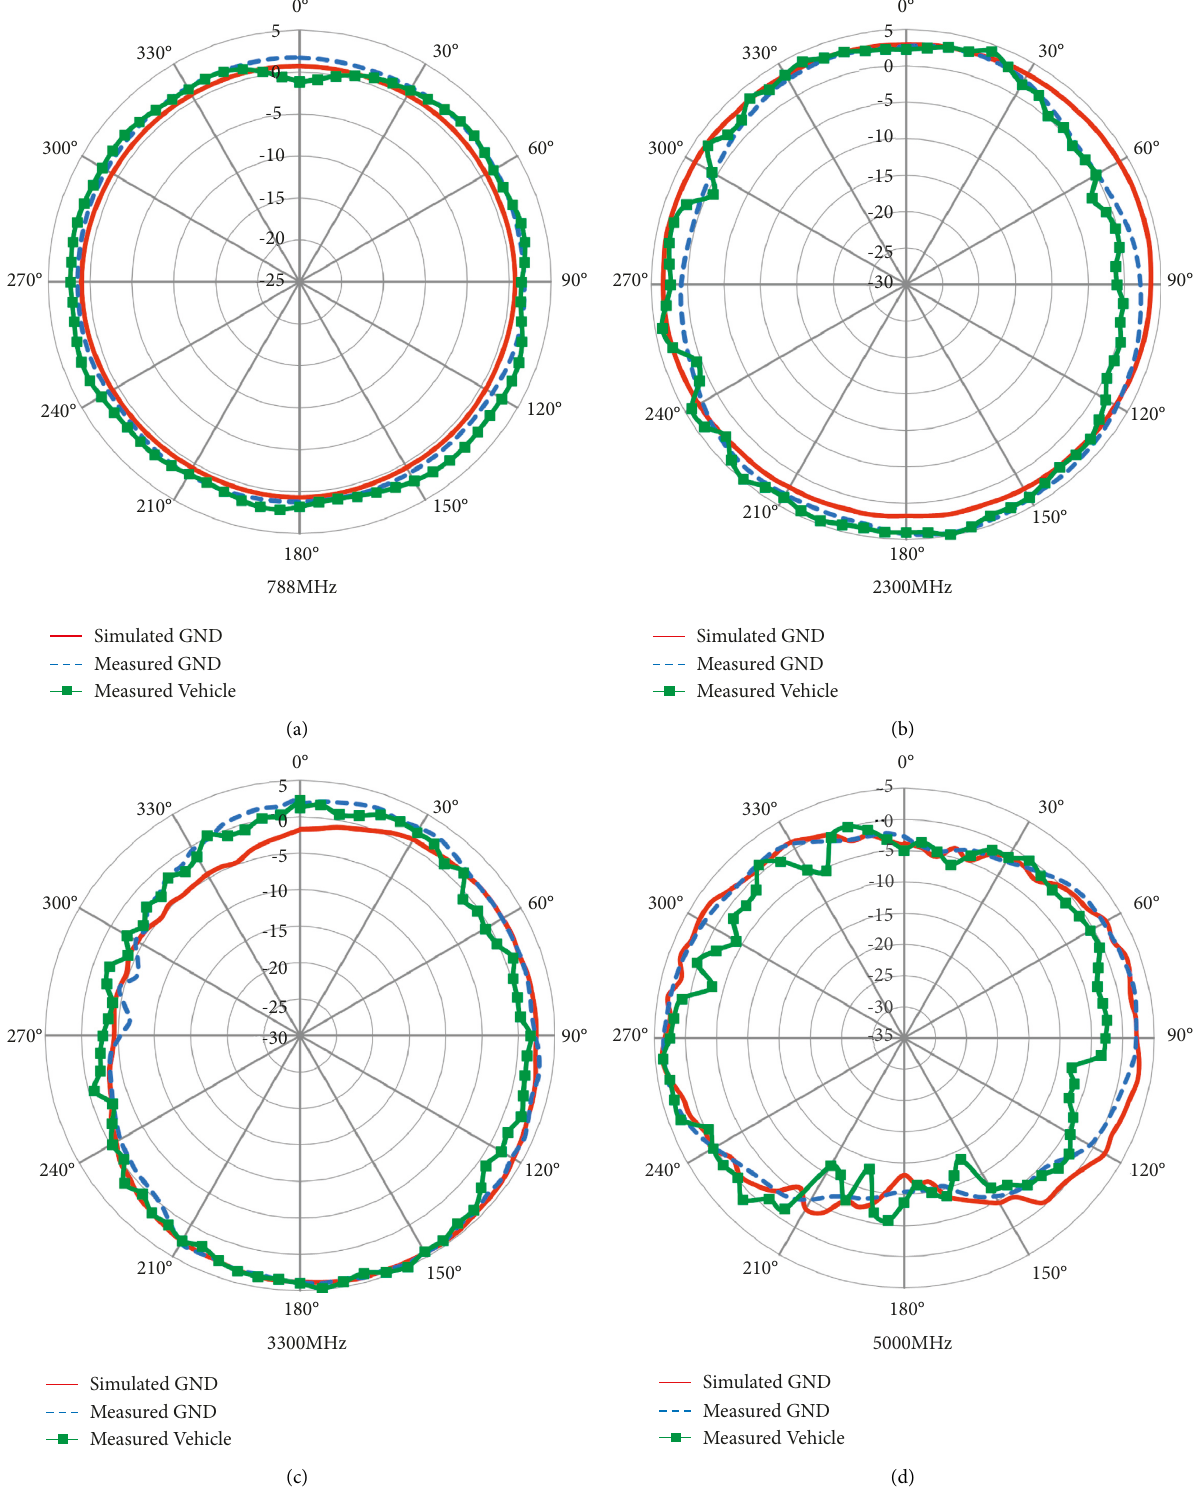
Figure 11: Antenna cellular radiation pattern simulated on ground plane and measured on ground plane and a vehicle at 80 ° elevation angle (0 ° is the direction of the front of the vehicle). (a) 788MHz. (b) 2300MHz. (c) 3300MHz. (d)